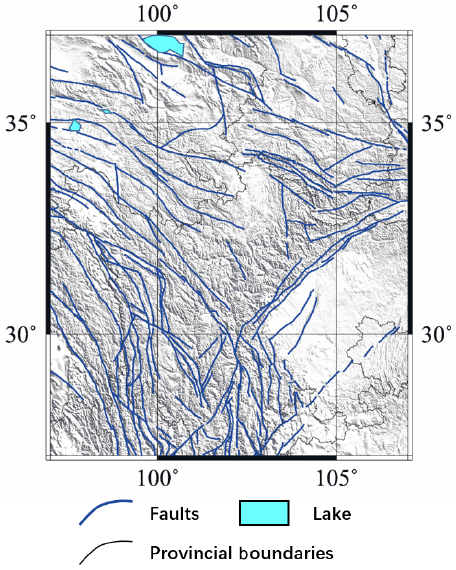
Figure 1. The distribution of faults in the eastern–southern Gansu province and its neighboring